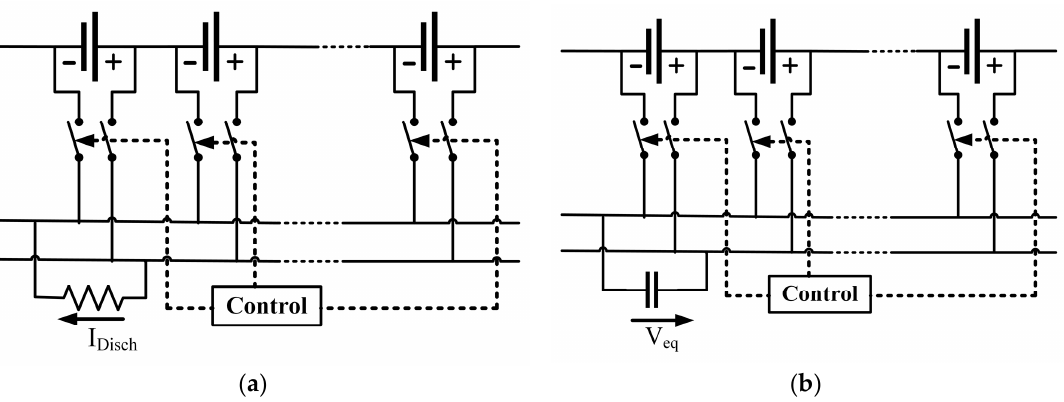
Figure 27. Equalizer configurations: ( a ) Resistive equalizer, extra power from any cell is burned up in the resistance; ( b ) Capacitive equalizer, excess energy is transferred to lower energy cells by switching of capacitors.